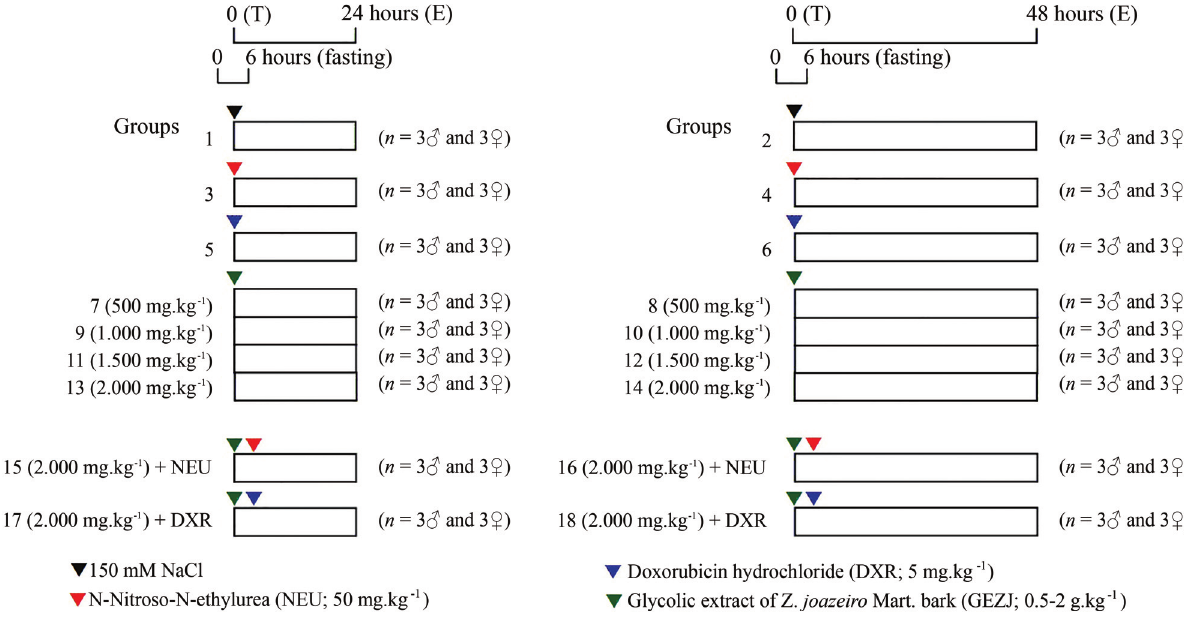
Figure 1 - Experimental protocol for assessing the mutagenic and antimutagenic activity of a glycolic extract of Z. joazeiro bark. T - treatment, E - eutha- nasia and n - number of